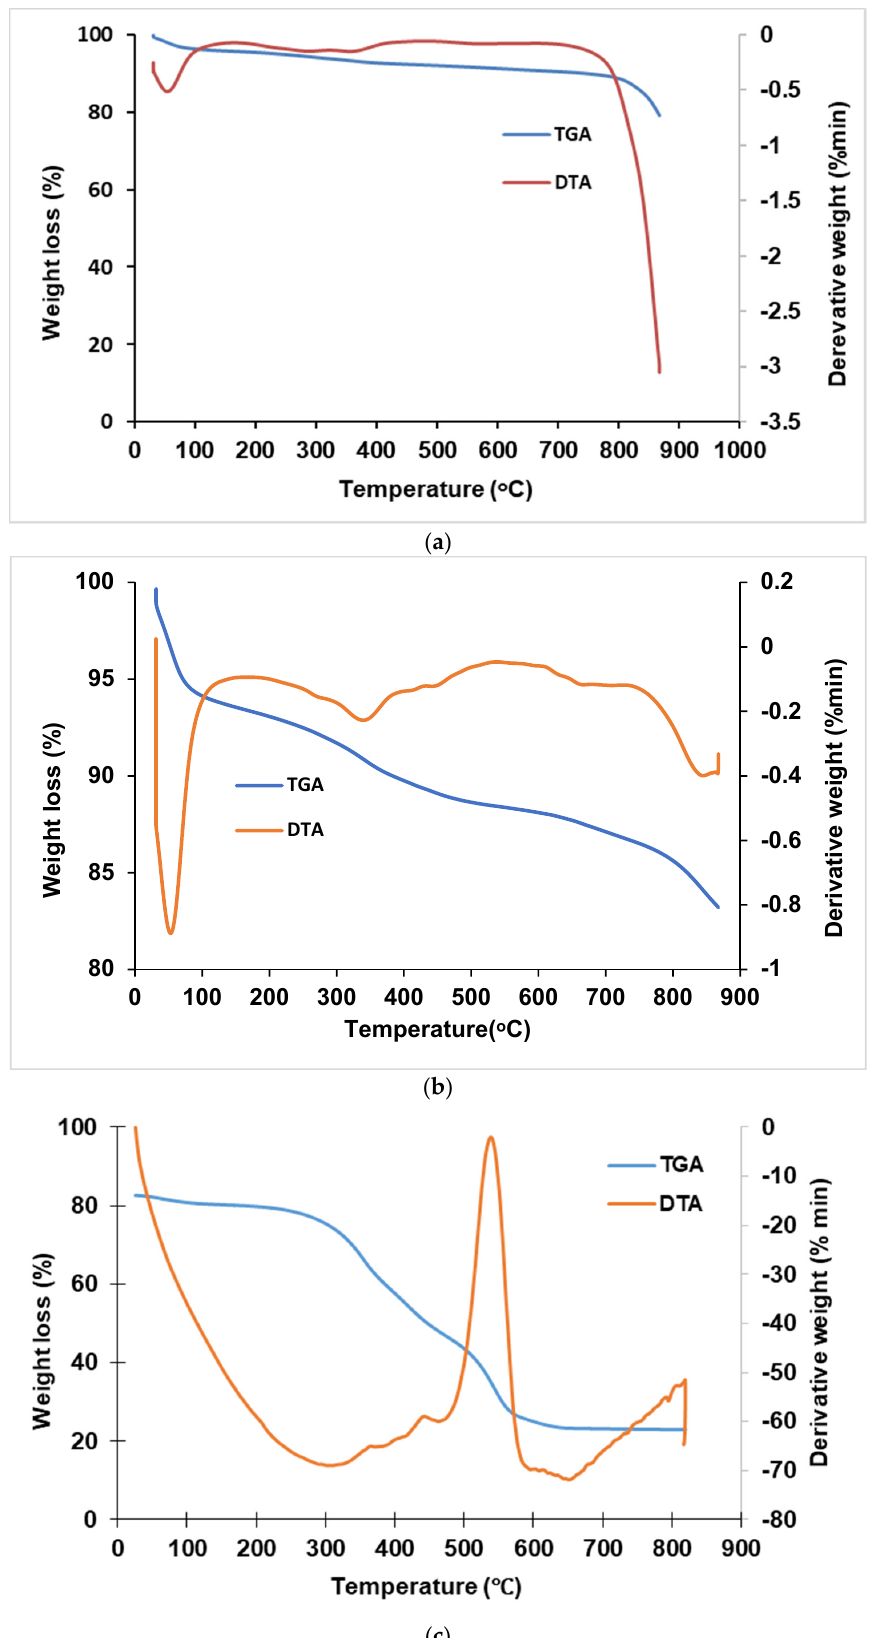
Figure 6. TGA and DTA of AC-Fe 3 O 4 ( a ), AC-Fe 3 O 4 -SiO 2 ( b ), and AC-Fe 3 O 4 -SiO 2 -PEI ( c